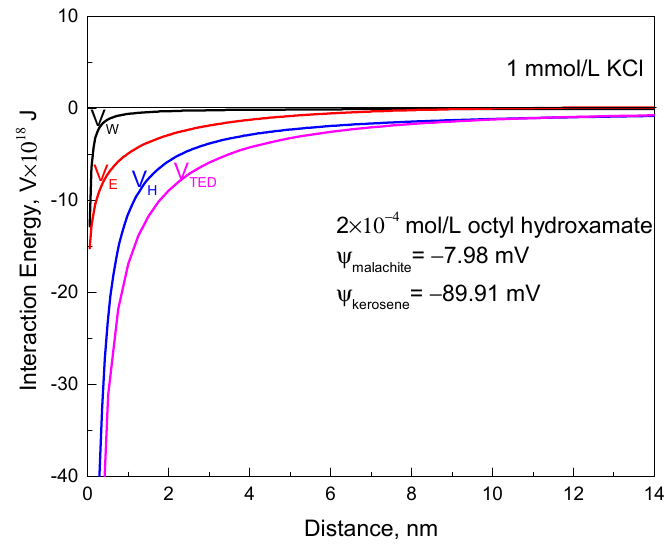
Figure 10. The interaction energy between malachite particles and 0.05 wt % octyl hydroxamate treated kerosene droplets as a function of separation distance, malachite radius: 2.10 µm and kerosene radius: 0.27 µm.